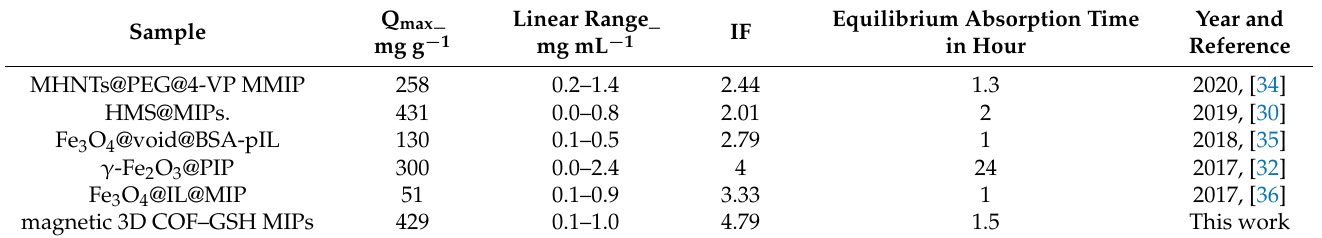
Table 1. Literature comparison of BSA imprinting on magnetic molecularly imprinted polymers